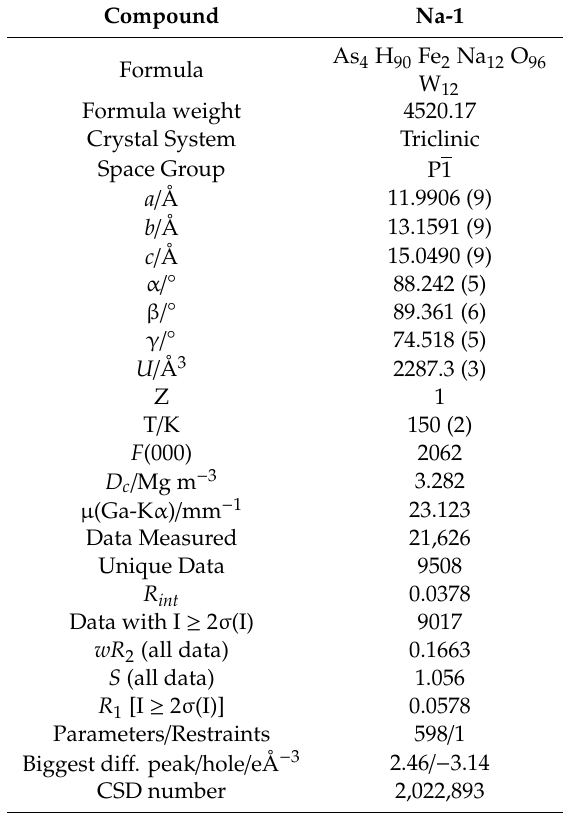
Table 1. Crystal